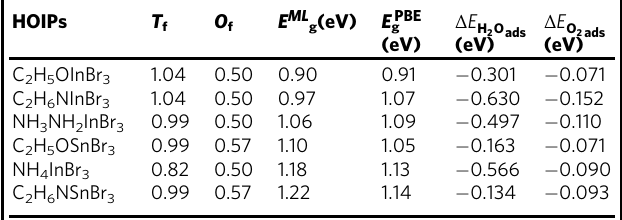
Table 2 Six selected HOIPs with relevant statistics